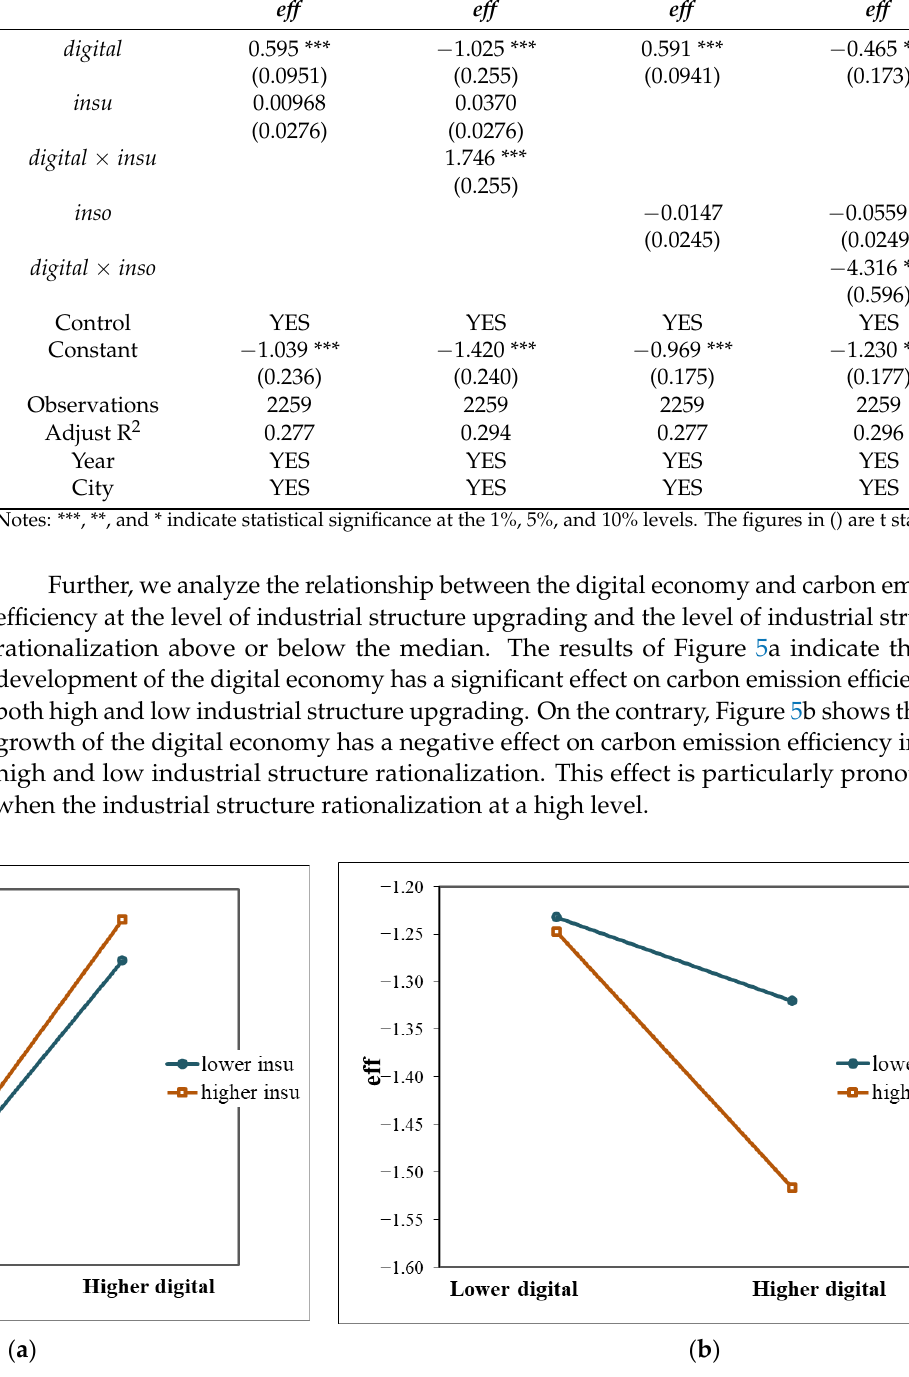
Figure 5. Moderating effect of industrial transformation. ( a ) Industrial structure upgrading; ( b ) Industrial structure rationalization.